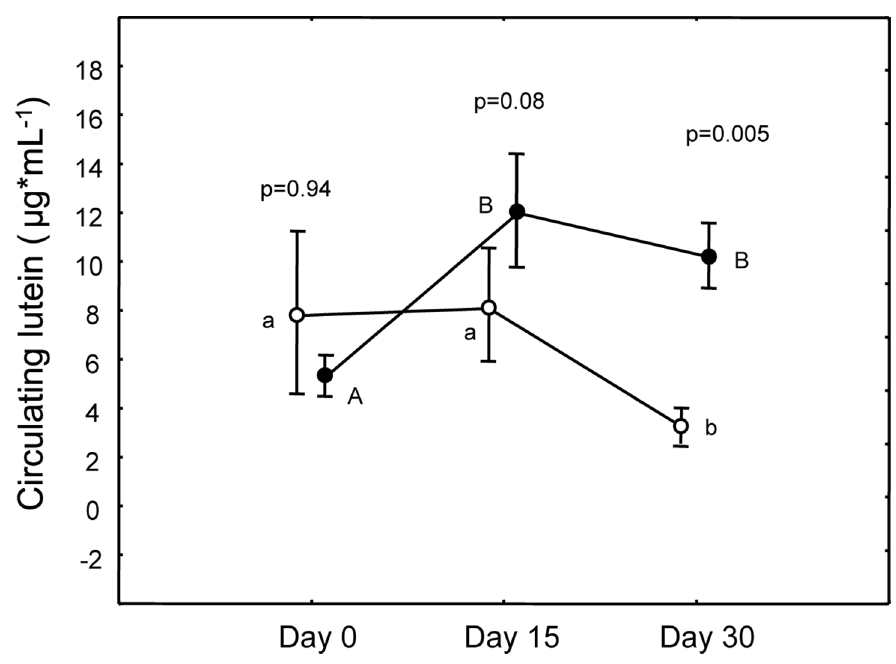
Fig. 2. Variation of circulating carotenoids in the two treatments. Full circles represent Caro-birds. P values refer to pairwise differences of least square means between groups within the same day (reported only when significant) and within each group between different days (different letters indicate significant difference with what observed on day 0; capital for Caro-group and small letters for